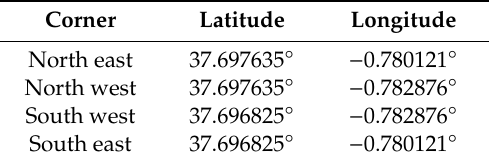
Table 3. GPS coordinates of the area